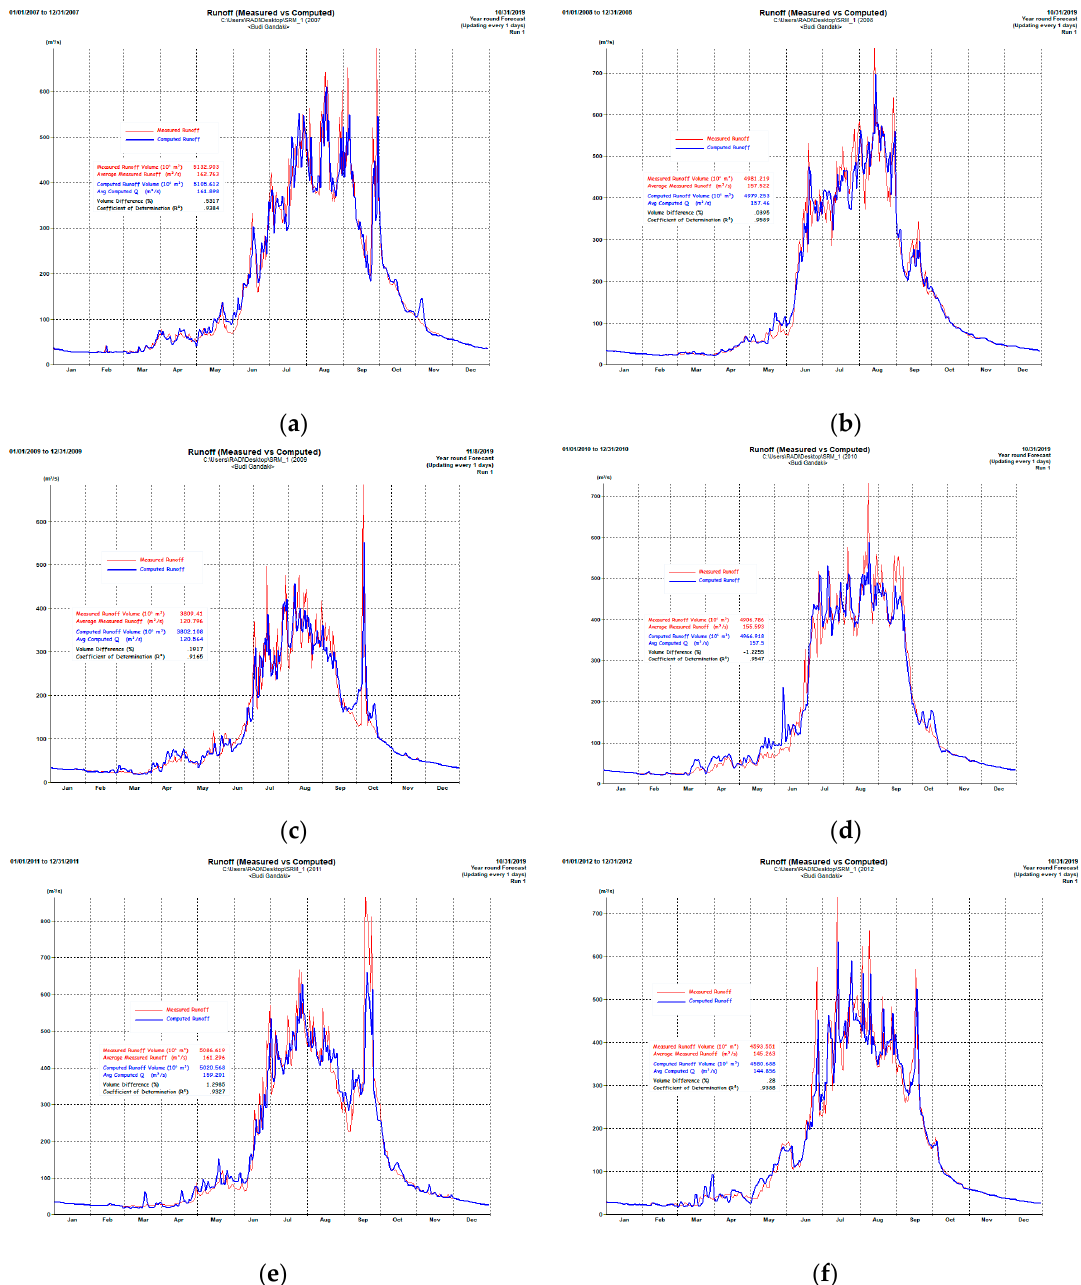
Figure 7. Measured and computed daily river discharge in SRM forecast mode; ( a ) 2007, ( b ) 2008, ( c ) 2009, ( d ) 2010, ( e ) 2011, ( f ) 2012.